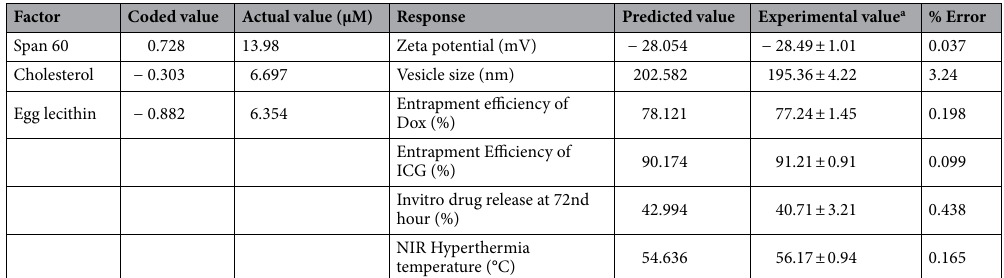
Table 5. Prediction and validation of optimized formulation (DIP). a Data represented as the mean ± SD (n =